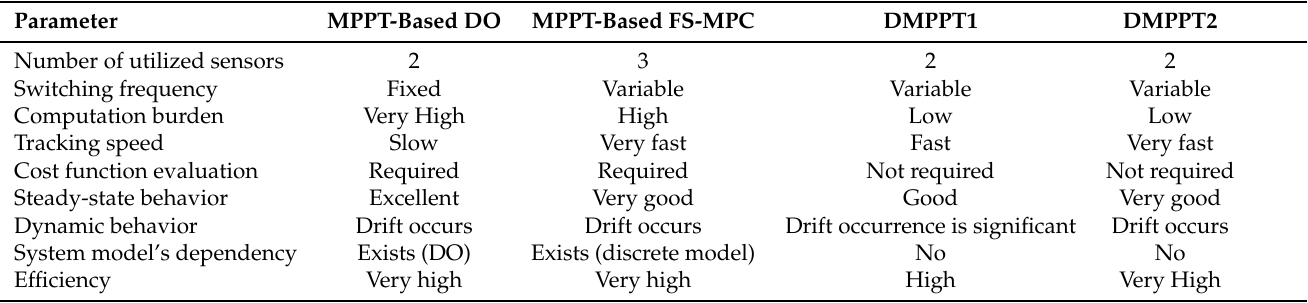
Table 7. Comparative assessment of the MPPT